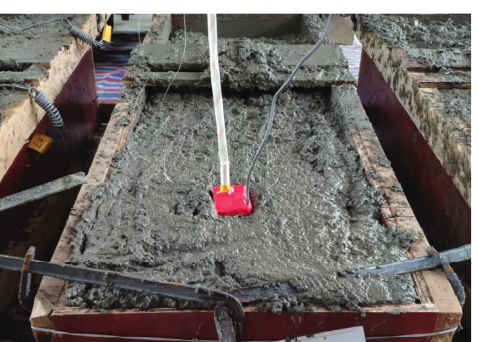
Figure 8: Installation of displacement